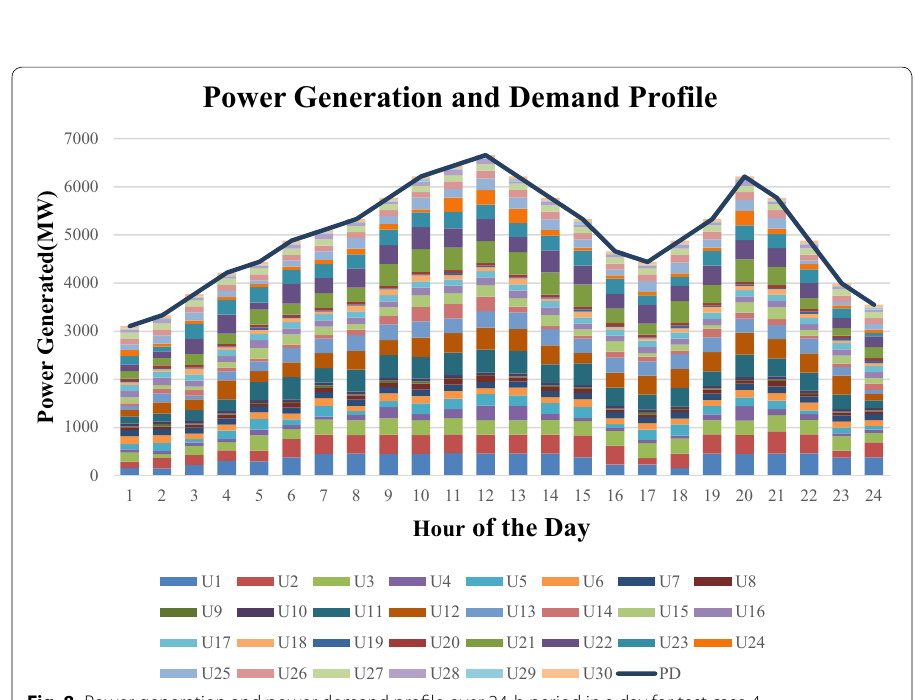
Fig. 8 Power generation and power demand profile over 24-h period in a day for test case 4